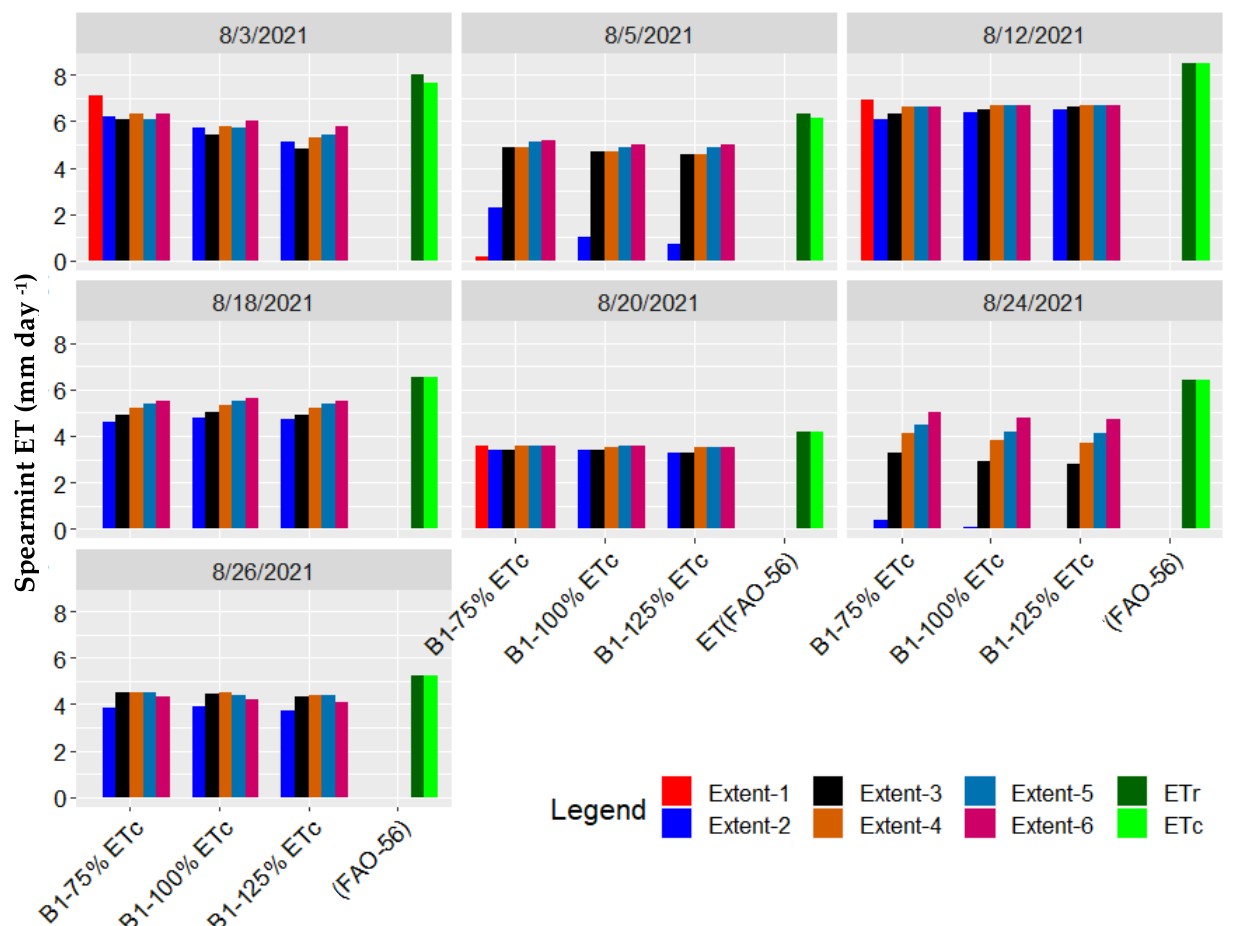
Figure 6. Estimated ET c from generated UAS-METRIC maps with different Extent sizes at different irrigation levels (75% ET c , 100% ET c and 125% ET c of Block 1).